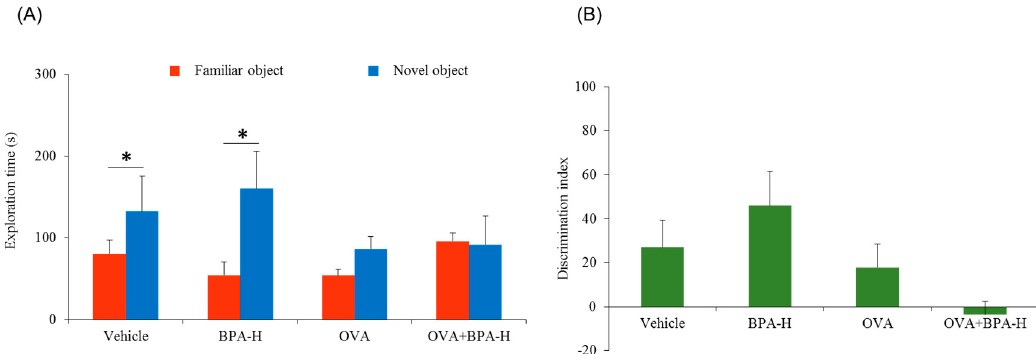
Figure 2. Novel object recognition test. ( A ) Test phase showing exploration time to familial or novel object, and ( B ) discrimination ability between familial and novel object. Each bar represents the mean + SE ( n = 5~6, * p < 0.05).